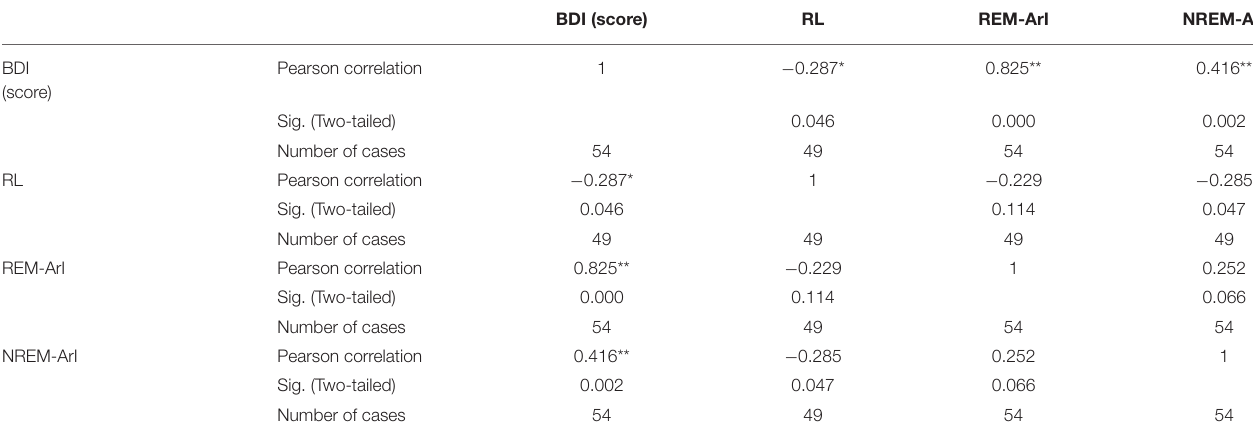
TABLE 3 | Correlation analysis between the BDI score and various indicators of sleep structure after 3 months of follow-up.